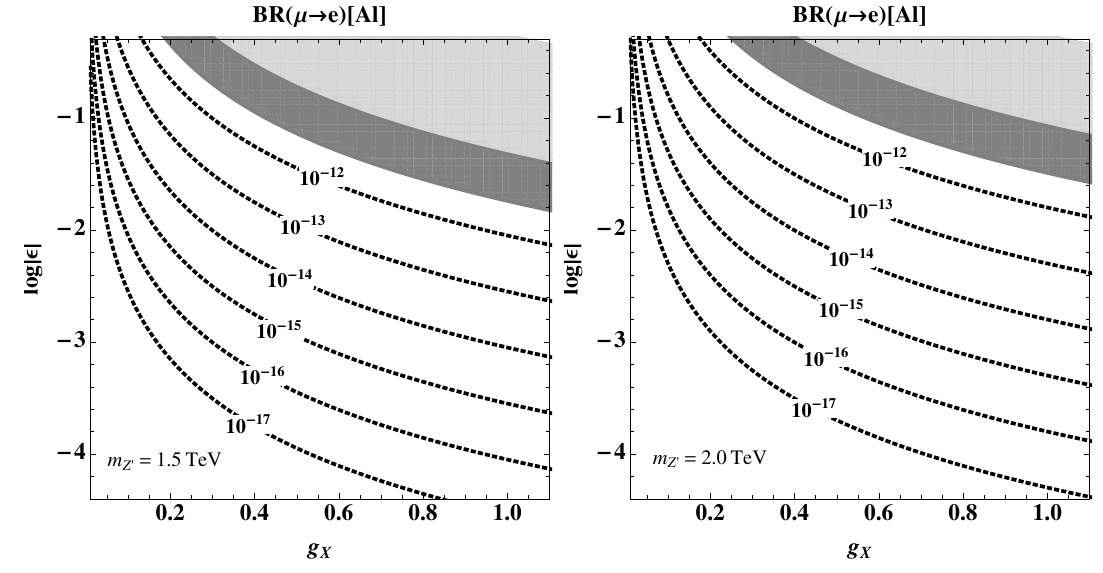
Figure 4 . BR ( (cid:22) ! e ) on 27 Al as a function of f g X ; log j (cid:15) jg (cid:12)xing m Z 0 = 1 : 5(2 : 0) TeV for left(right) 13 plot where gray(light-gray) shaded region is excluded by current (cid:22) ! e(cid:13) BR ( (cid:22) ! e BR on 197 Au [55]) 79